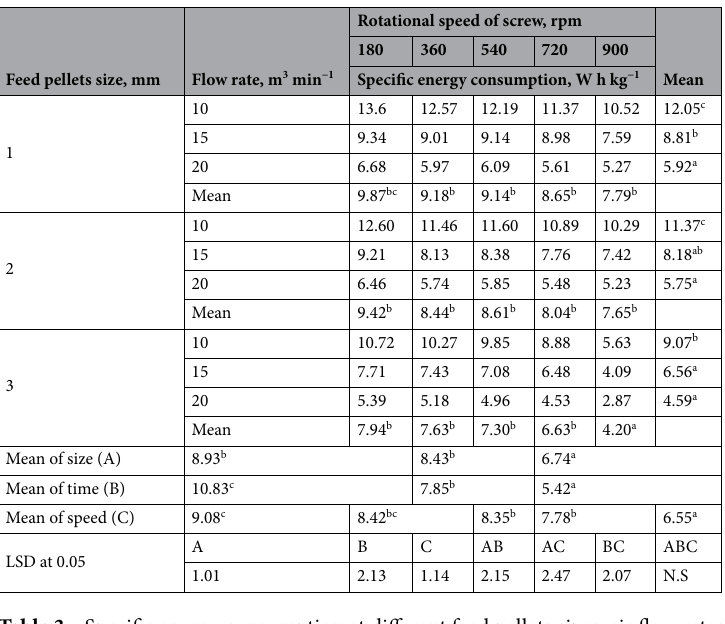
Table 3. Specific energy consumption at different feed pellets sizes, air flow rates and rotational speeds of screw. Superscripts letters mean significantly between the treatments (statistical analysis).